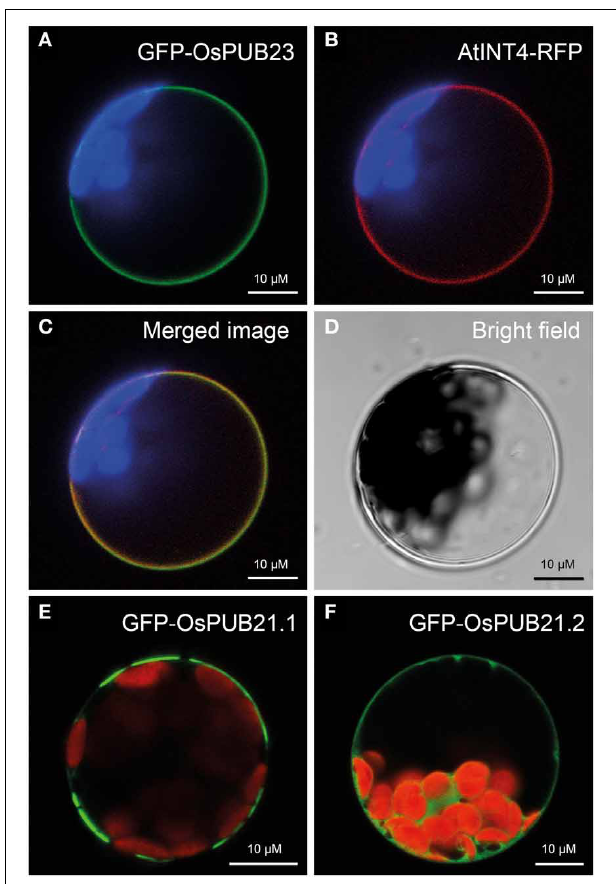
FIGURE 2 | Localization of rice SAUL-type PUB-ARM proteins at the plasma membrane. (A) Localization of GFP-OsPUB23 fusion proteins at the plasma membrane of Arabidopsis protoplasts. Confocal laser scanning microscopy detected fluorescence of GFP-OsPUB23 proteins depicted in green at the plasma membrane of protoplasts co-expressing GFP-OsPUB23 and AtINT4-RFP. Chlorophyll auto-fluorescence within the chloroplasts is depicted in blue. (B) Localization of AtINT4-RFP fusion proteins at the plasma membrane. Confocal laser scanning microscopy detected fluorescence of AtINT4-RFP proteins depicted in red at the plasma membrane of protoplasts co-expressing GFP-OsPUB23 and AtINT4-RFP. Chlorophyll auto-fluorescence within the chloroplasts is depicted in blue. (C) Merged image of (A,B) . Yellow signals derived from the overlap of green and red fluorescences from (A,B) . (D) Bright filed image of the protoplast analyzed in (A–C) . (E) Localization of GFP-OsPUB21.1 fusion proteins at the plasma membrane. Confocal laser scanning microscopy detected fluorescence of GFP-OsPUB21.1 proteins depicted in green at the plasma membrane of transformed protoplasts. Chlorophyll auto-fluorescence within the chloroplasts is depicted in red. (F) Localization of GFP-OsPUB21.2 fusion proteins at the plasma membrane. Confocal laser scanning microscopy detected fluorescence of GFP-OsPUB21.1 proteins depicted in green in the cytosol of transformed Arabidopsis protoplasts. Chlorophyll auto-fluorescence within the chloroplasts is depicted in red.